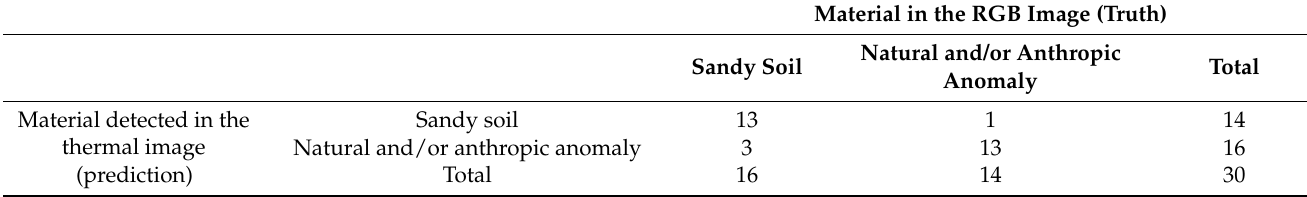
Material detected in the thermal image